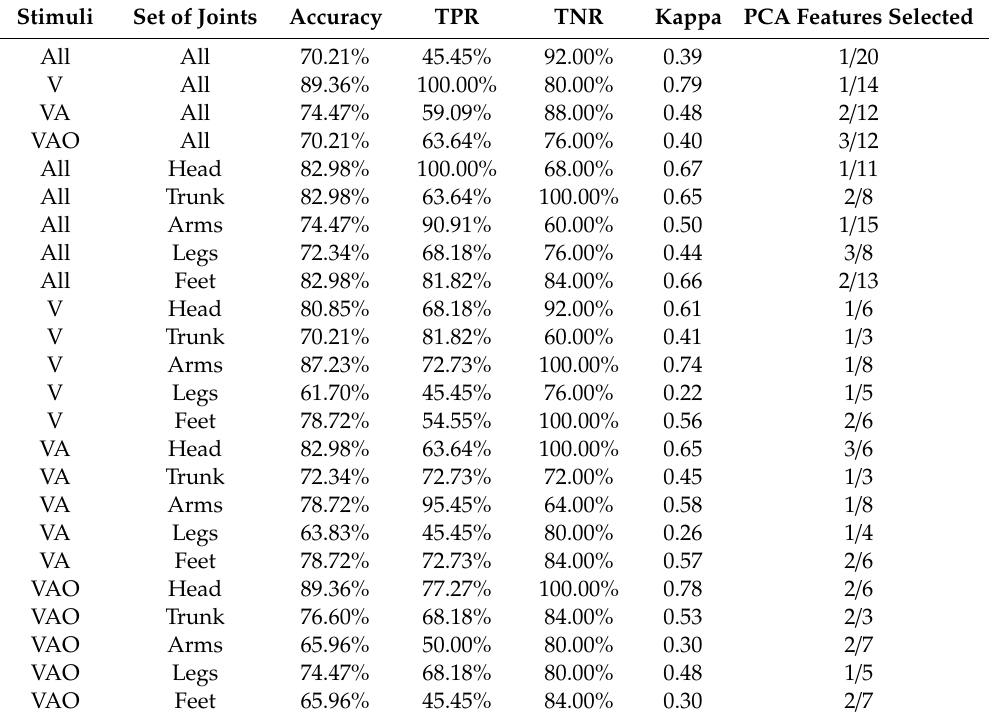
Table 2. Detailed level of autism spectrum disorder (ASD) recognition of each model including